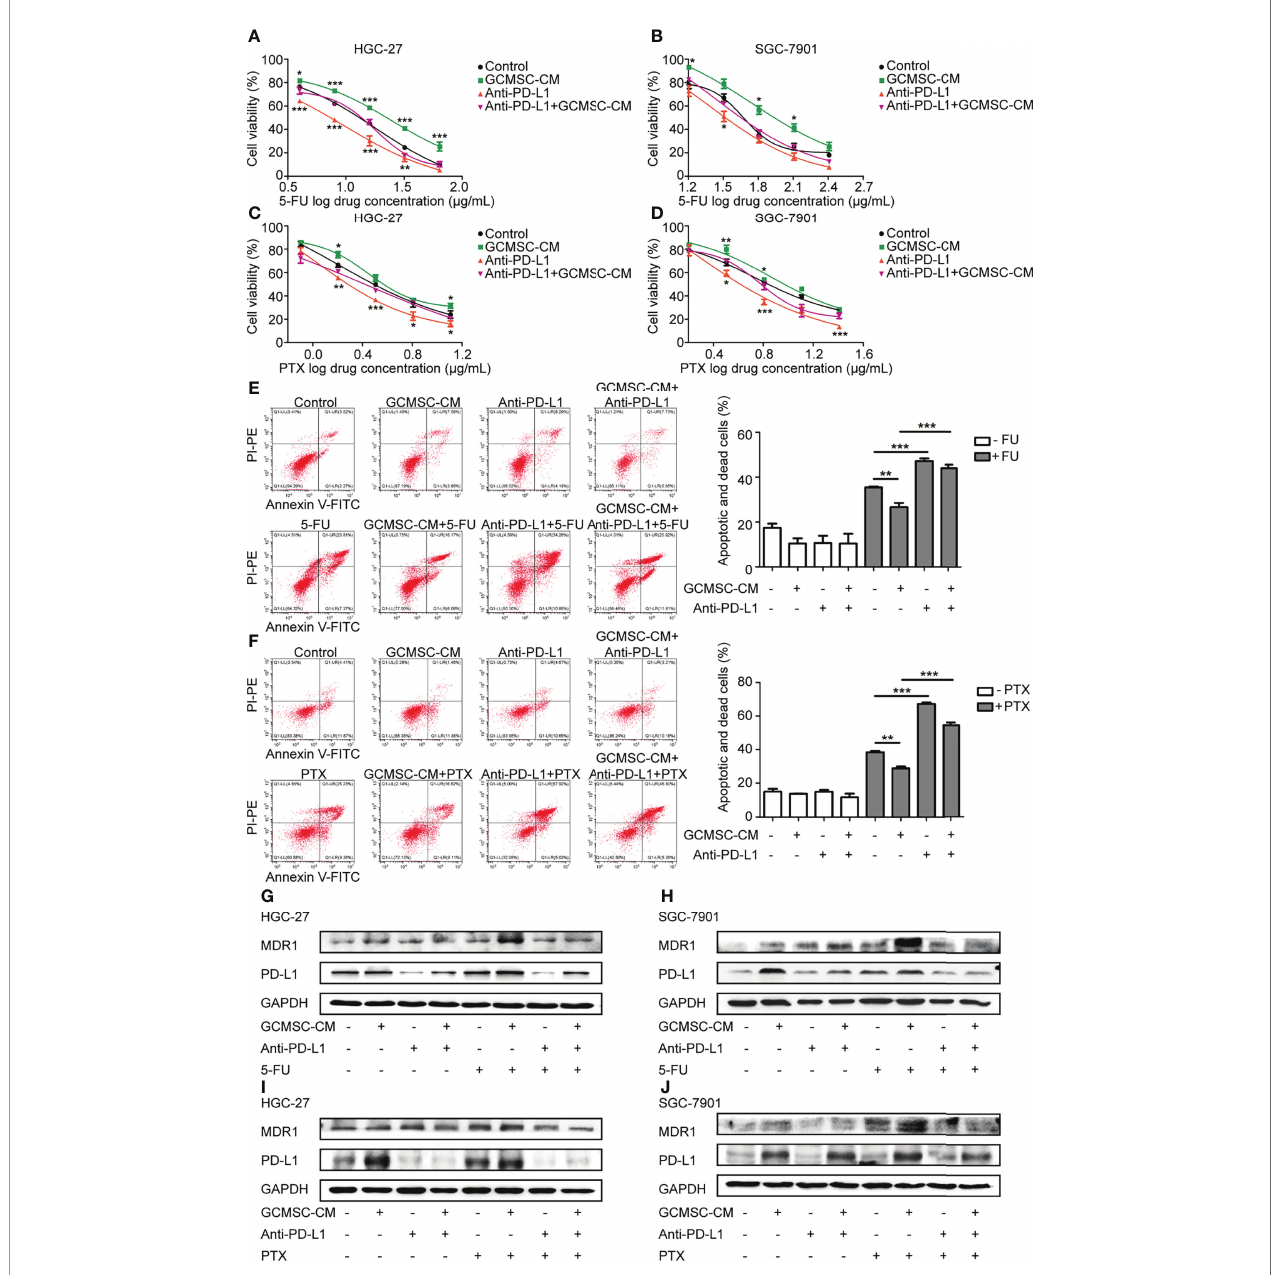
FIGURE 1 | GCMSC-CM enhances GC cell resistance to 5-FU and PTX, while PD-L1 blocking weakens these effects. (A – D) HGC-27 and SGC-7901 cells co-cultured with GCMSC-CM and anti-PD-L1 were treated with different concentrations of 5-FU and PTX to detect cell viability using CCK-8 assay. (E, F) Annexin V-FITC/PI fl ow cytometry assay was used to analyze the apoptosis rate of HGC-27 cells. Panels on the right are quanti fi ed images. (G – J) PD-L1 and MDR1 levels in HGC-27 and SGC- 7901 cells were examined by Western blot. * p < 0.05, ** p < 0.01, *** p < 0.001. Concentration of PD-L1 neutralizing antibody was 2 m g/mL